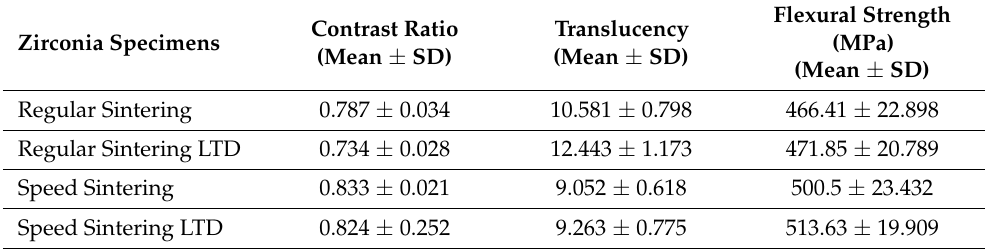
Flexural Strength Contrast Ratio Translucency (Mean ± SD) (Mean ± SD)